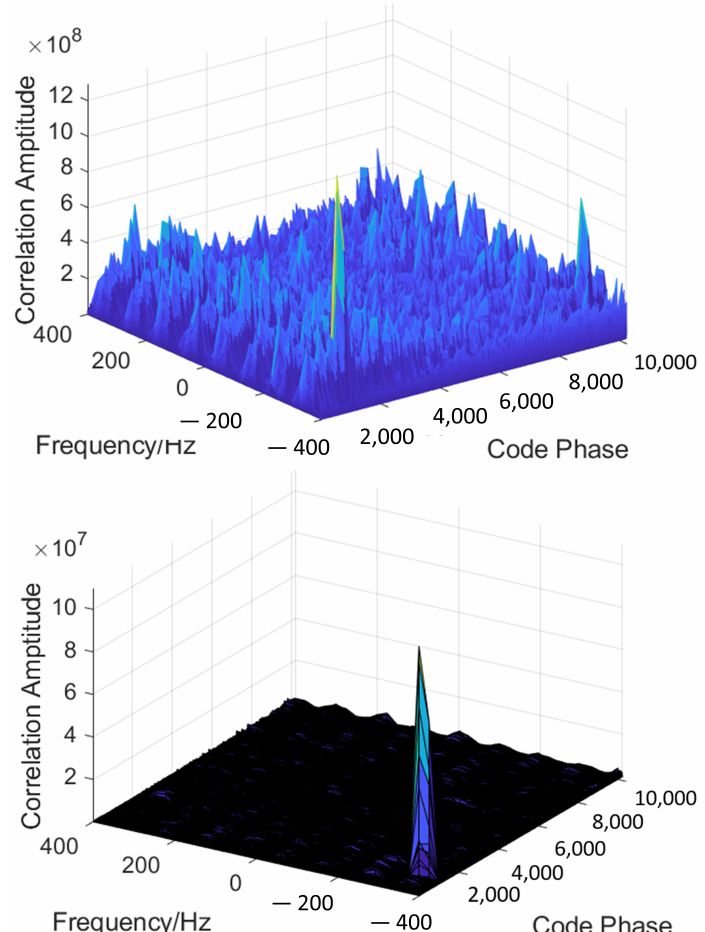
Figure 11. CAF of the waveform with PRN = 19. ( a ) CAF waveform before interference mitigation is performed; ( b ) In the chirp signal interference scenario, the waveform of CAF after interference mitigation is performed. JSNR = 30